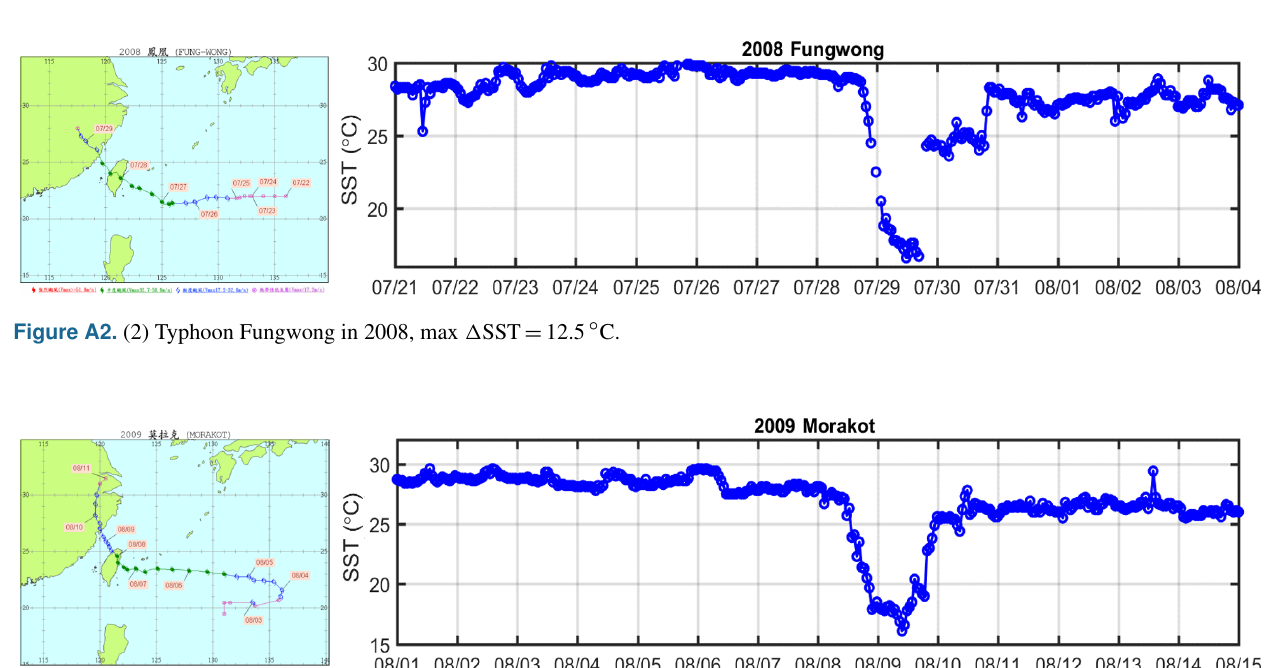
Figure A3. (3) Typhoon Morakot in 2009, max (cid:49) SST = 12.3 ◦